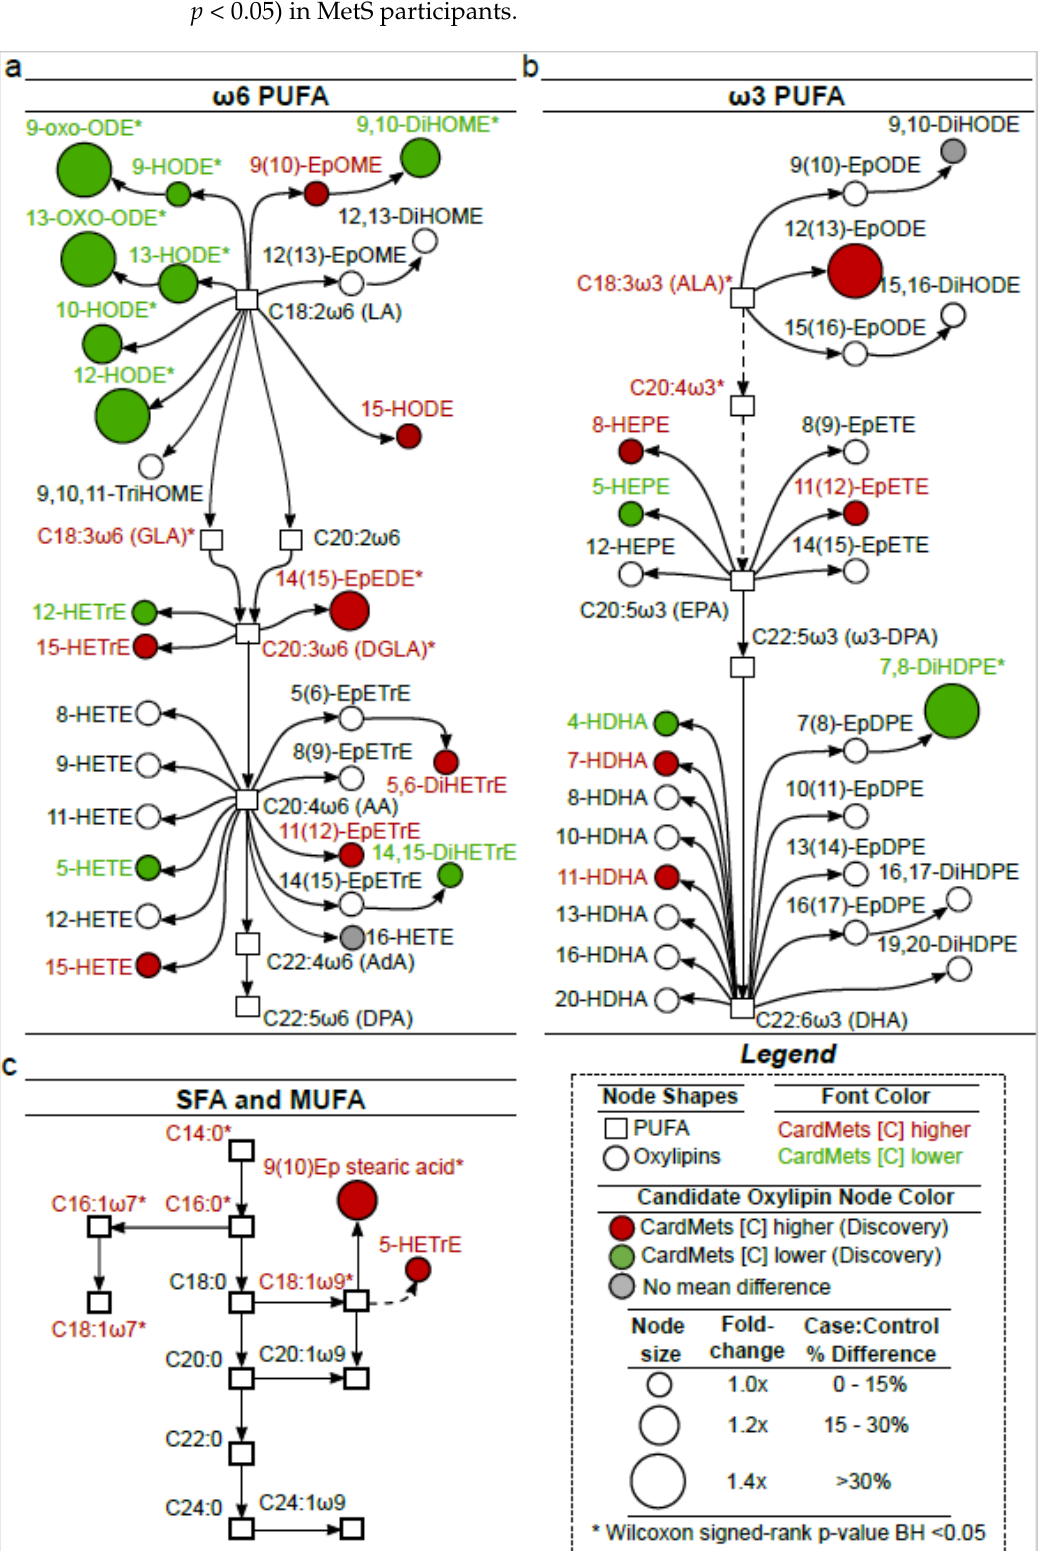
Figure 3. Biological origin of the candidate oxylipins discriminating participants with MetS. Metabolic pathway showing all oxylipins ( n = 54) and the fatty acids ( n = 25) (represented by circles and squares, respectively) measured in the Discovery and Replication cross-sectional studies. Pathways of oxylipins biosynthesis derived from omega-6 PUFAs ( a ), omega-3 PUFAs ( b ) and SFA/MUFAs ( c ). The oxylipins selected in the Discovery and Replication studies (candidates oxylipins n = 29) are highlighted in color. Differences in concentration between controls and MetS participants in the Discovery study are highlighted in red (higher concentration in CardMetS group vs. Control), green (lower concentration in CardMetS group vs. Control) or gray (no difference). Dash lines represent indirect pathways including intermediate metabolites. Size of nodes represents the fold change be- tween the two groups. Significant oxylipins from Wilcoxon signed-rank are represented by a star. LA: Linoleic Acid; GLA: γ -Linolenic Acid; DGLA: Dihomo- γ -Linolenic Acid; AA: Arachidonic Acid; AdA: Adrenic Acid; DPA: Docosapentaenoic Acid; ALA: α -Linolenic Acid; EPA: Eicosapentaenoic Acid; DHA: Docosahexaenoic Acid; PUFA: PolyUnsaturated Fatty Acids; SFA: Saturated Fatty Ac- ids; MUFA: MonoUnsaturated Fatty Acids.